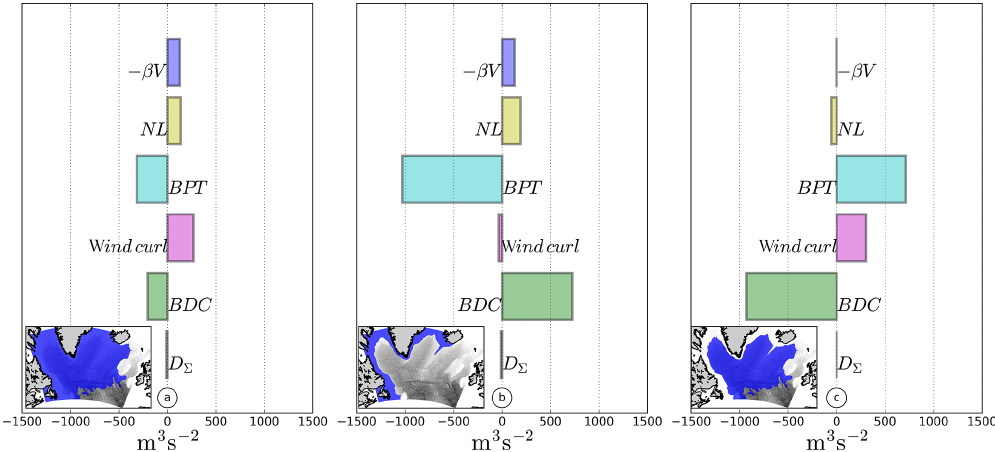
Figure 8. (a) Bottom pressure torque, (b) − f w b , (c) f smoothed with a 25km Gaussian kernel.